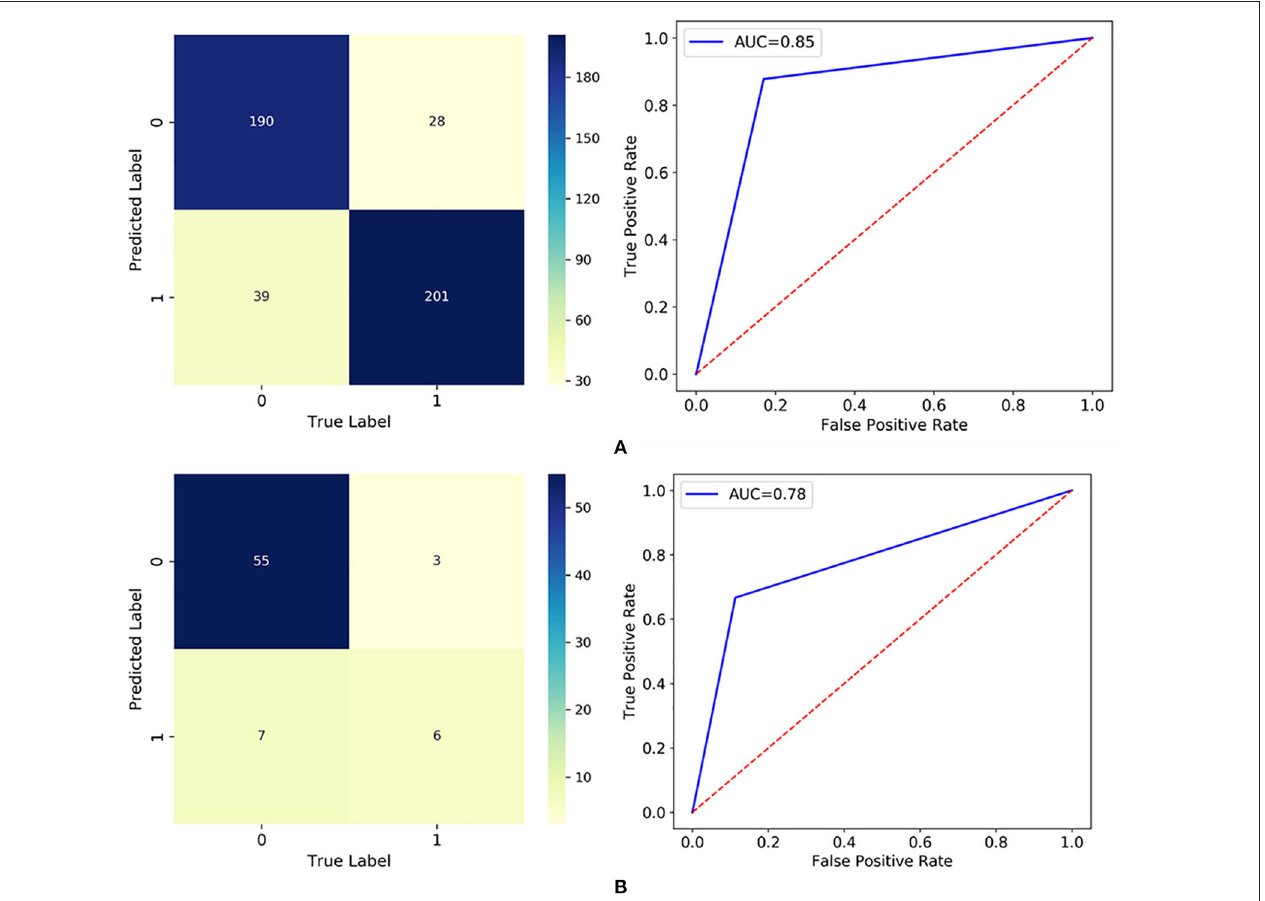
FIGURE 3 | Classification results visualized by the confusion matrix and ROC curve in: (A) the training set; and (B) the test set.